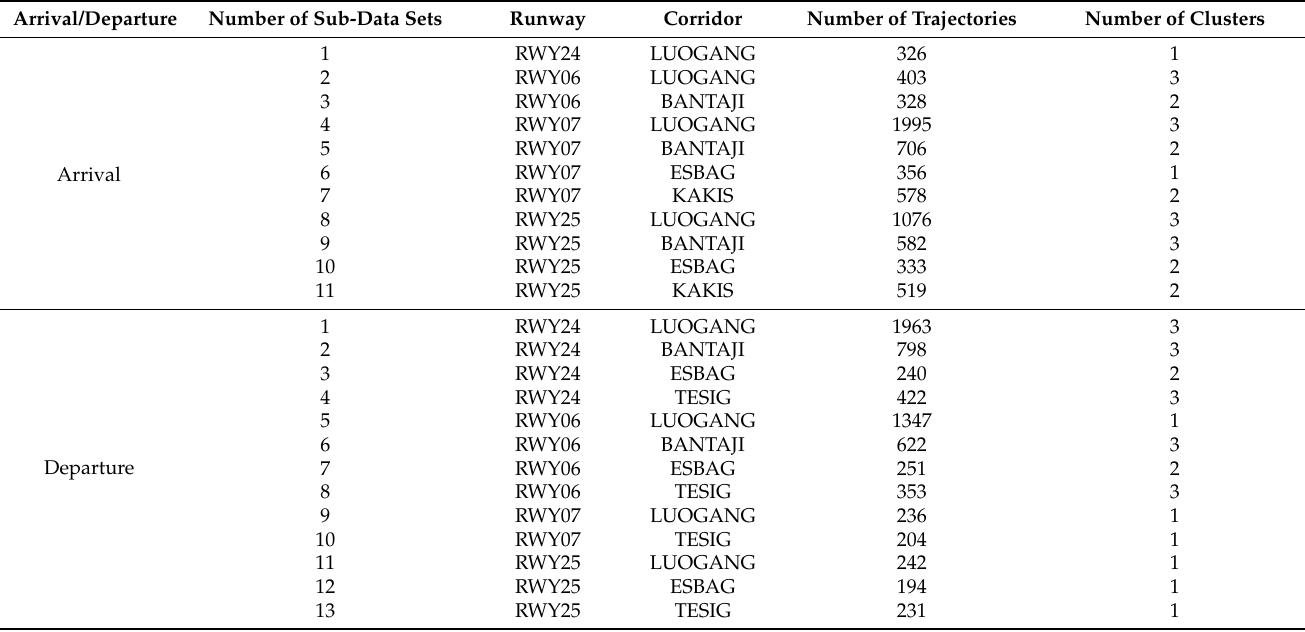
Figure 6. Histogram of trajectory length. Table 1. Basic information of each